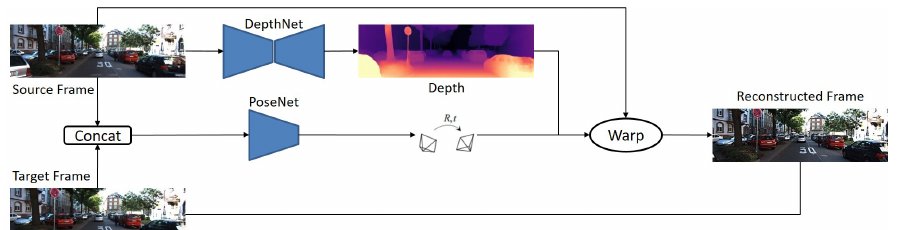
Figure 3. Main network structure for MDE [34]. This network contain two sub-networks: DepthNet for predicting the depth map and PoseNet for estimating the camera pose.